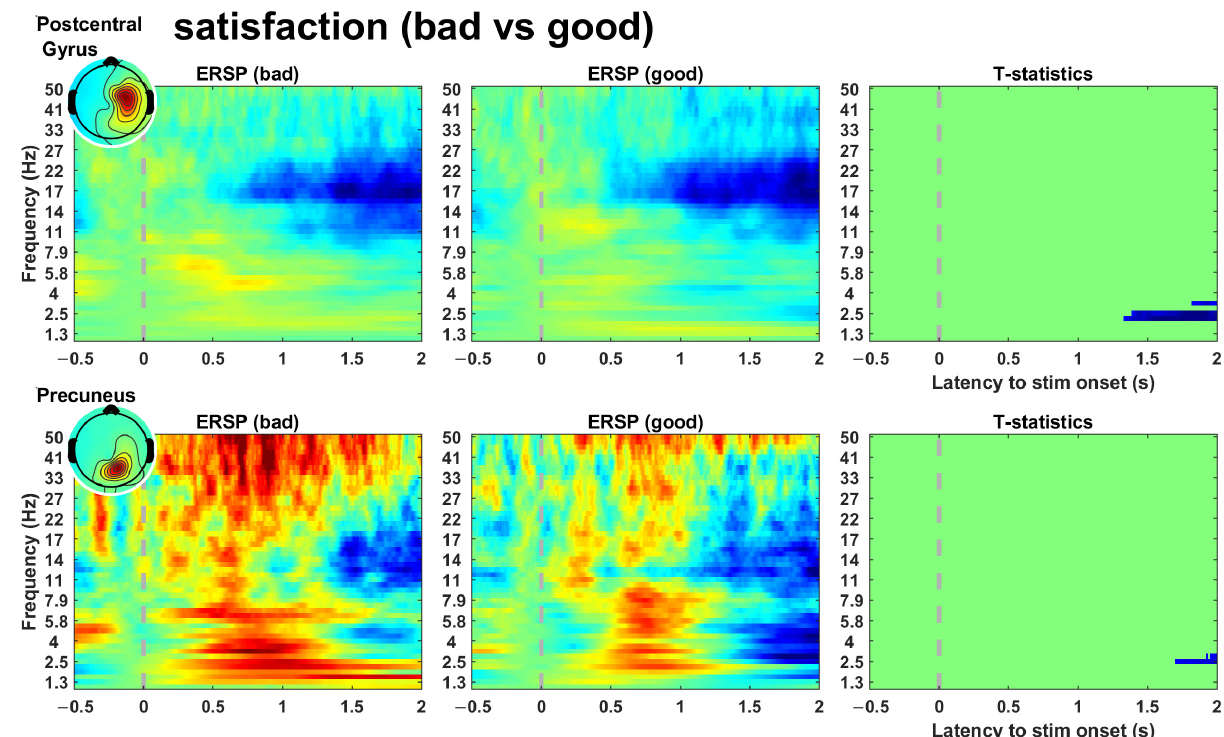
Figure 3. Event-related spectral perturbation of clusters including a significant area in the comparison of satisfaction. The dotted line represents the onset of the “Go” cue. In each figure set, the third column represents t-statistics and the significant area. This plot indicates that satisfaction is determined dominantly in the final phase of control.